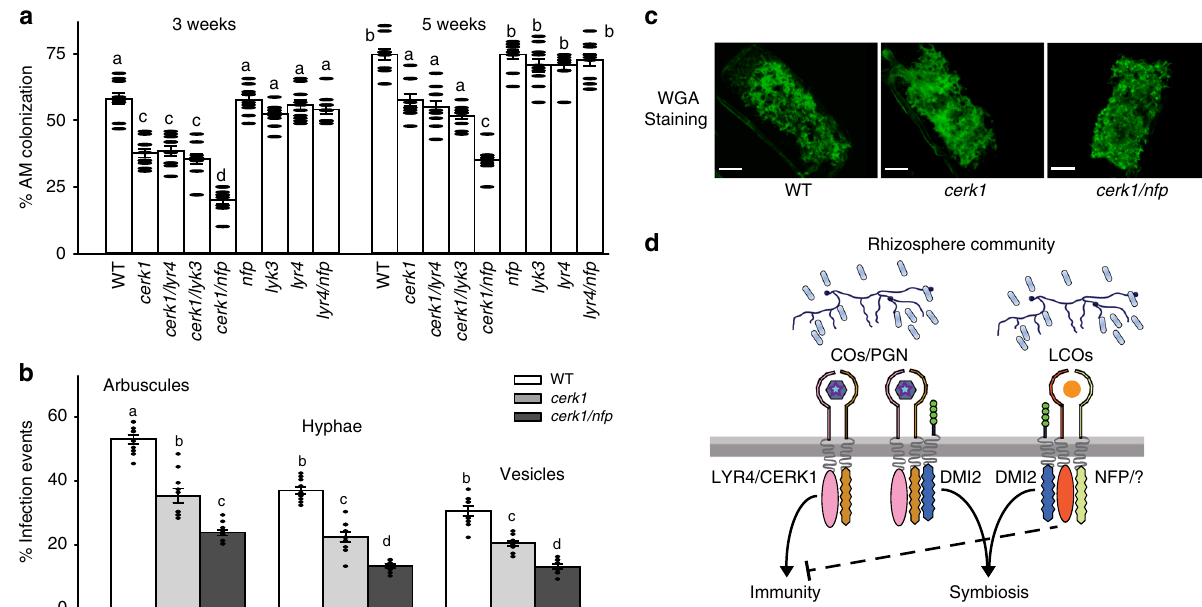
Fig. 7 MtCERK1 and NFP are required for arbuscular mycorrhizal colonization. a R. irregularis colonization shown as percent root length colonization assessed at 3 and 5 weeks post inoculation. b Individual fungal structures were quanti fi ed at 3 weeks post inoculation. This experiment was repeated three times with similar results. c Representative images of arbuscules in wild type and mutant plants. Scale bar = 10 µ m. a , b Letters denote statistically signi fi cant groupings calculated with Mann – Whitney Rank Sum Test (mean ± s.e.m., n = 10; P < 0.05). d A model for COs/PGN and LCO recognition during symbiosis. The LYR4/CERK1 receptor complex responds to COs and PGN with activation of immunity and symbiosis signalling. In contrast, the LCO receptor activates symbiosis signalling. Activation of symbiosis signalling by LCOs suppresses immunity signalling. Note the co-receptor DMI2 is necessary for COs/PGN and LCO promotion of symbiosis signalling, but is not required for COs/PGN induction of immunity